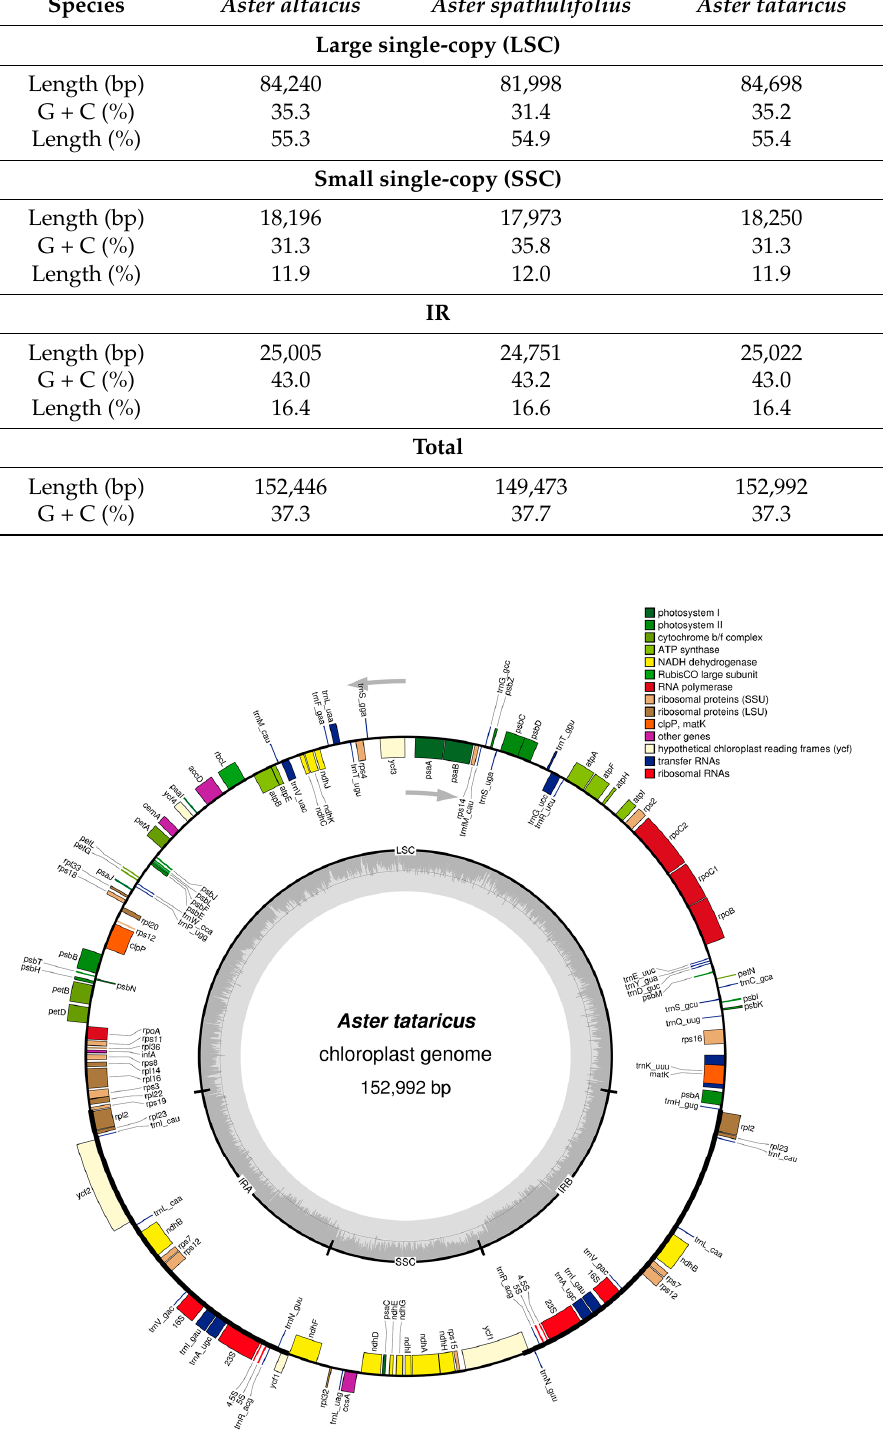
Table 1. Summary of complete chloroplast genomes for three Aster species.